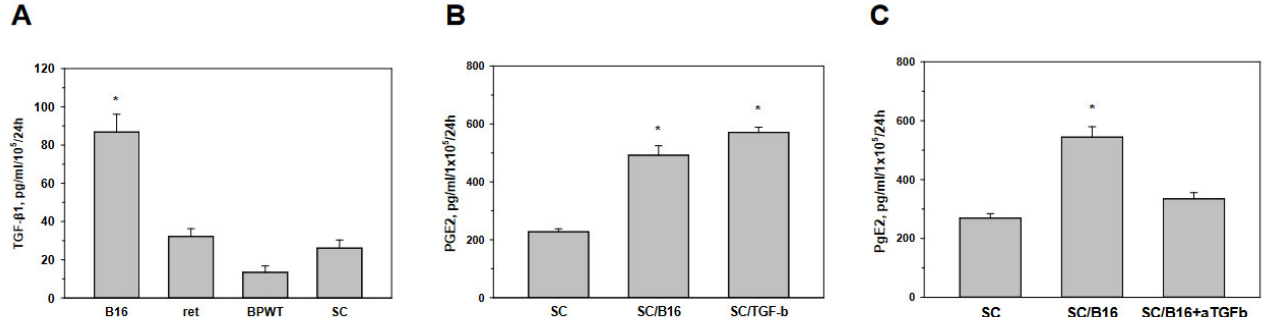
Figure 4. Tumor-derived TGF-β induced PGE2 production by Schwann cells. Adult SC were isolated from the sciatic nerve of C57BL/6 mice, cultured and purified as described in M&M. TGF-β production by melanoma B16, ret and BPWT cells and SC were assessed by ELISA in cell-free supernatant obtained from tumor cells and SC after they were washed and re- cultured for 24 h ( A ). SC were also co-cultured with medium (SC), B16-conditioned medium (10% v / v ) (SC/B16) and 10 ng/mL TGF-β1 (SC/TGF-b) for 24 h, washed and cultured for additional 24 h. PGE2 levels were then determined in cell- free supernatants by ELISA ( B ). In addition, SC were cultured with medium (SC), B16-conditioned medium (10% v / v ) (SC/B16) and conditioned medium from B16 cells that were cultured in the presence of anti-TGF-β neutralizing antibody (SC/B1b+aTFGb). Control and tumor-treated SC were then washed and cultured for another 24 h to assess PGE2 produc- tion by ELISA ( C ). Results are the mean ± SEM. *, p < 0.001 versus control SC group (n = 3, One-way